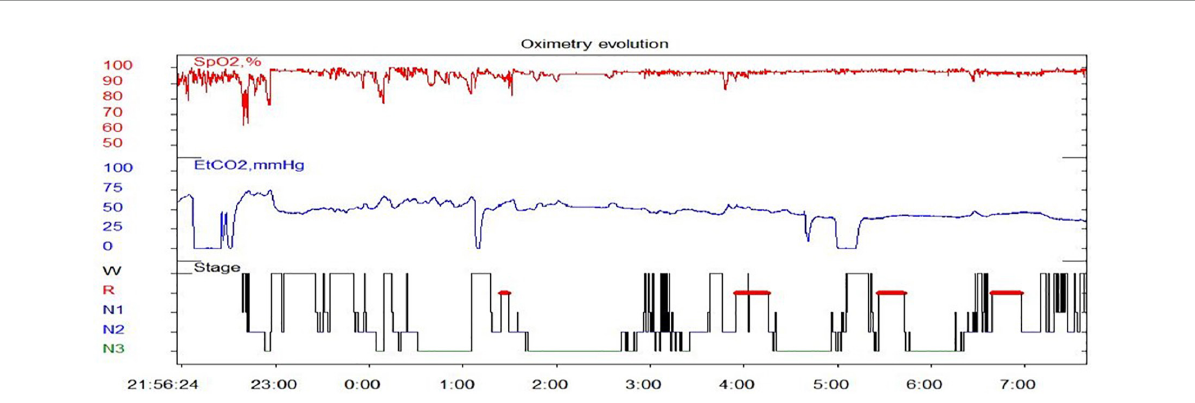
FIGURE1 Nocturnal pulse oximetry, TcPCO 2 evolution, and sleep stage presentation in PSG, starting at 1 a.m. of the BPAP pressure titration. Hypoventilation was seen (SpO 2 between 60 and 98%; PCO 2 maximum 75 mmHg) for 4 h during the night, accompanied by sleep structure disruption (recurrent arousal and inability to deep sleep). Sleep stage: W, wake; R, REM stage, N1, NREM stage 1; N2, NREM stage 2; N3, NREM stage